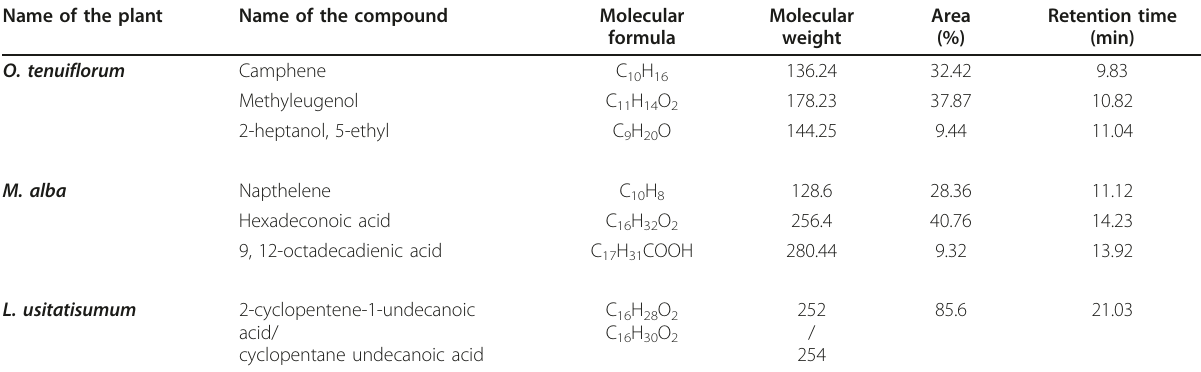
Table 4 GCMS Profile of extracts exhibiting ≥ 50% inhibition on PPA activity Name of the plant Name of the compound Molecular